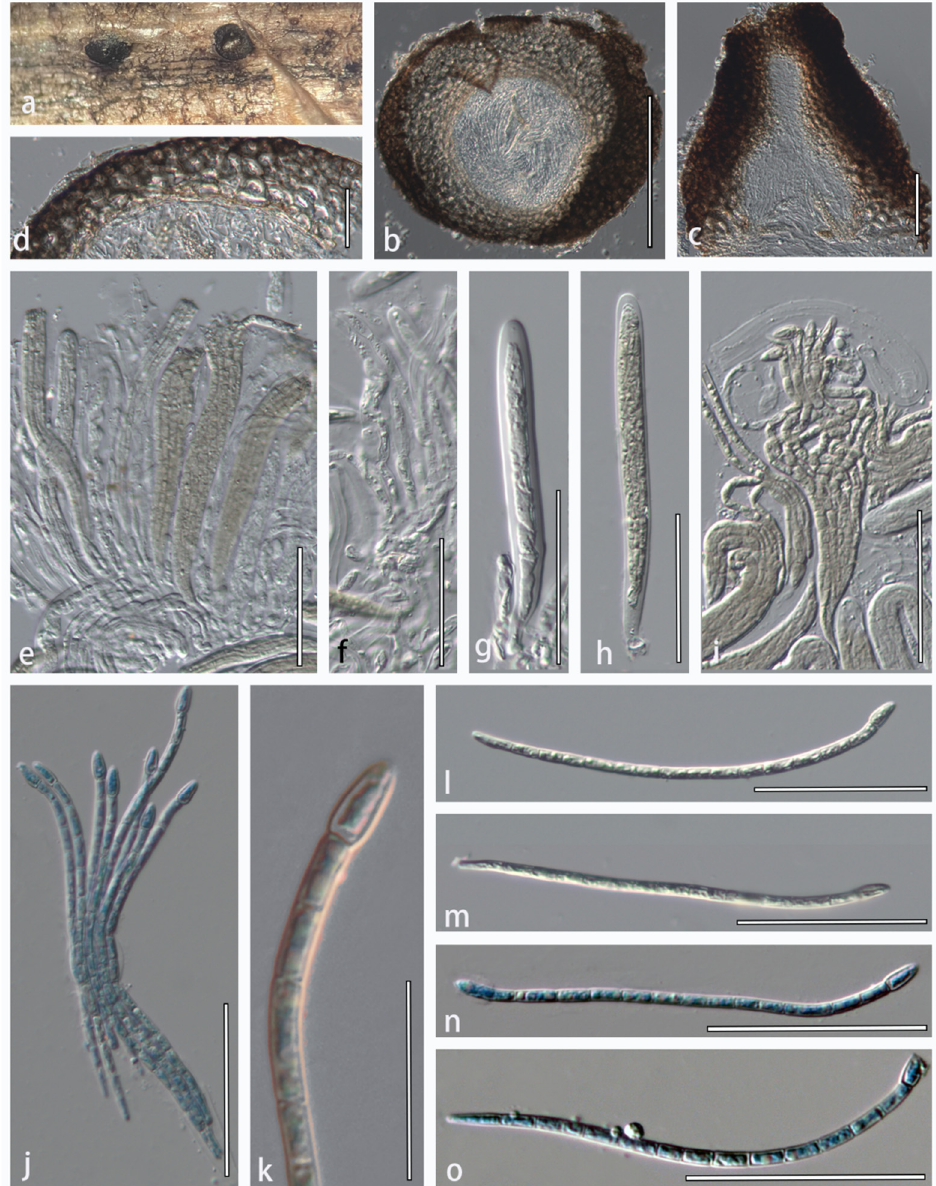
Figure 5. Alternariaster centaureae-diffusae (HMJAU 60188). ( a ) Appearance of ascomata on host substrate. ( b ) Vertical section of ascoma. ( c ) Ostiole with periphyses. ( d ) Close-up of peridium. ( e , g , h ) Immature and mature asci. ( f ) Pseudoparaphyses. ( i , j ) Fissitunicate asci. ( k ) Top part of ascospore. ( l – o ) Ascospores. ( j , n , o ) Ascospores were stained in cotton blue. Scale bars: ( b ) = 200 μ m; ( c , d , f – j , l – o ) = 50 μ m; ( e ) = 100 μ m; and ( k ) = 20 μ m.